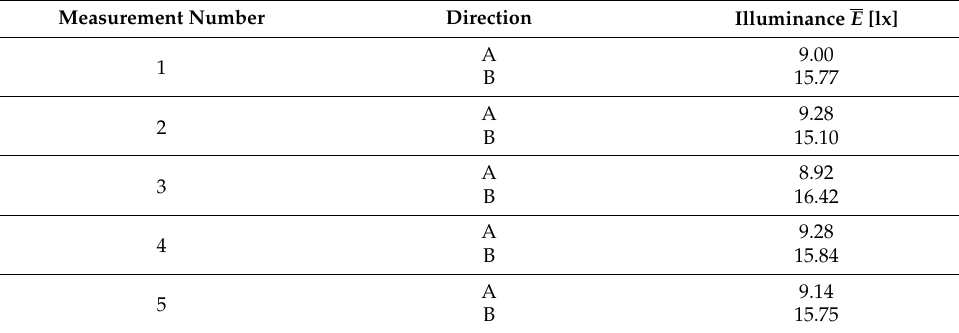
Table A4. Example of the results for measurement field No. 6.